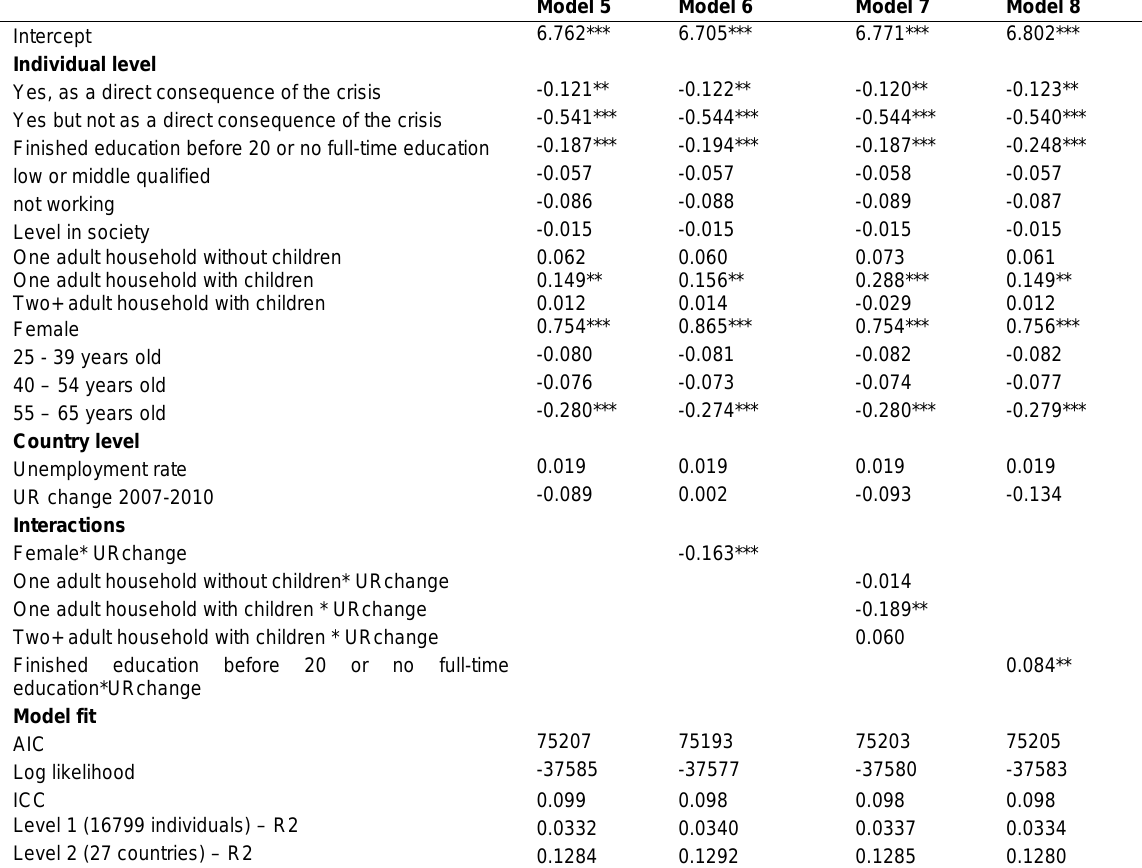
Table 2 . Multilevel regression models: dependent variable – index of gender attitudes (unstandardized regression coefficients). Macro level – unemployment rate change